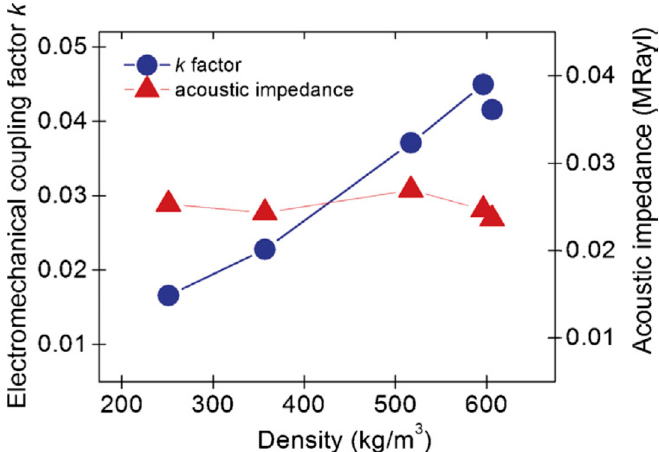
Figure 17. Acoustic impedance and electromechanical coupling factor k (obtained from the fit of dielectric spectra) for the given sample density range. Reprinted from [359], Copyright (2015), with permission from Elsevier.